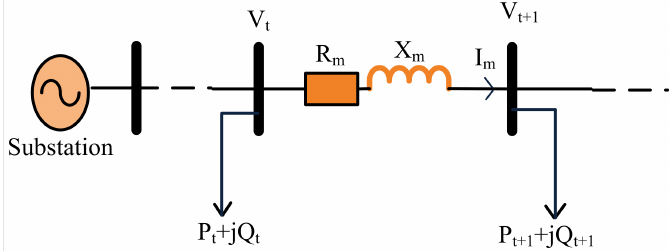
Figure 2. Single-line diagram of two consecutive nodes of a PDN.